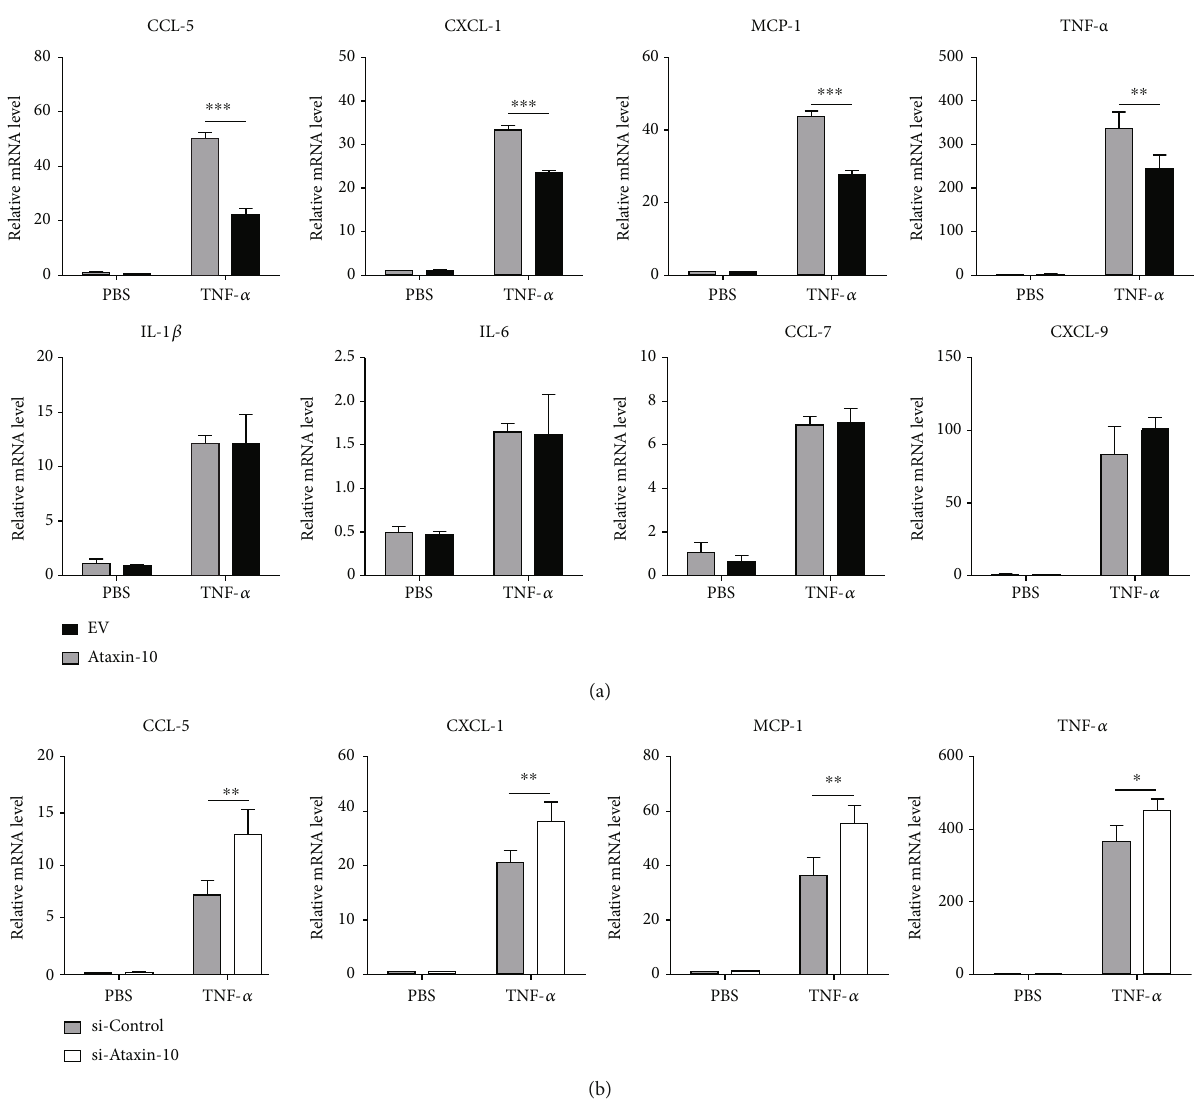
Figure 4: E ff ects of Ataxin-10 on chemokine/cytokine expression in TNF- α -stimulated HUVECs. (a) HUVECs were transfected with either EV or HA-Ataxin-10 for 48h, followed by incubation with TNF- α (10 ng/mL) for 4 h. Relative mRNA levels of IL-1 β , IL-6, CCL-5, CCL-7, CXCL-9, CXCL-1, MCP-1, and TNF- α were detected by qPCR, with β -actin as an internal control. ∗∗ p < 0 : 01 and ∗∗∗ p < 0 : 001 vs. EV. (b) Ataxin-10 was knocked down using siRNA and then stimulated with TNF- α for 4 h. mRNA levels of CCL-5, CXCL-1, MCP-1, and TNF- α were determined by qPCR. ∗ p < 0 : 05 and ∗∗ p < 0 : 01 vs. si-control